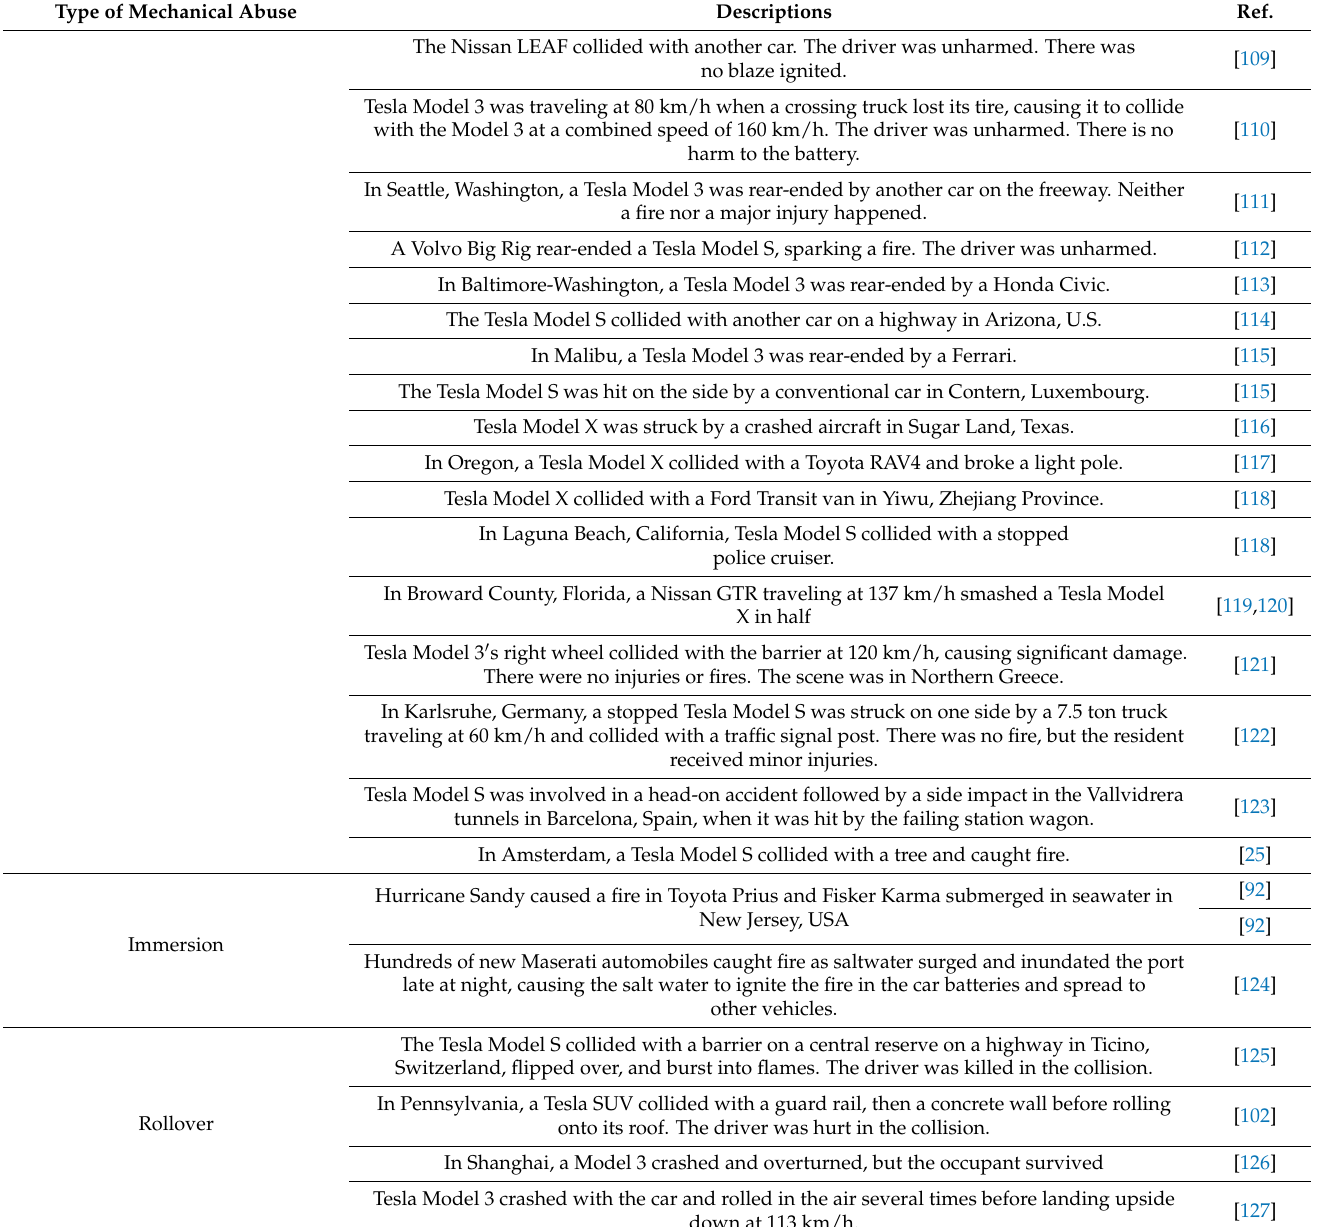
Table 3. Real-world EVs’ fire incidents in the form of mechanical